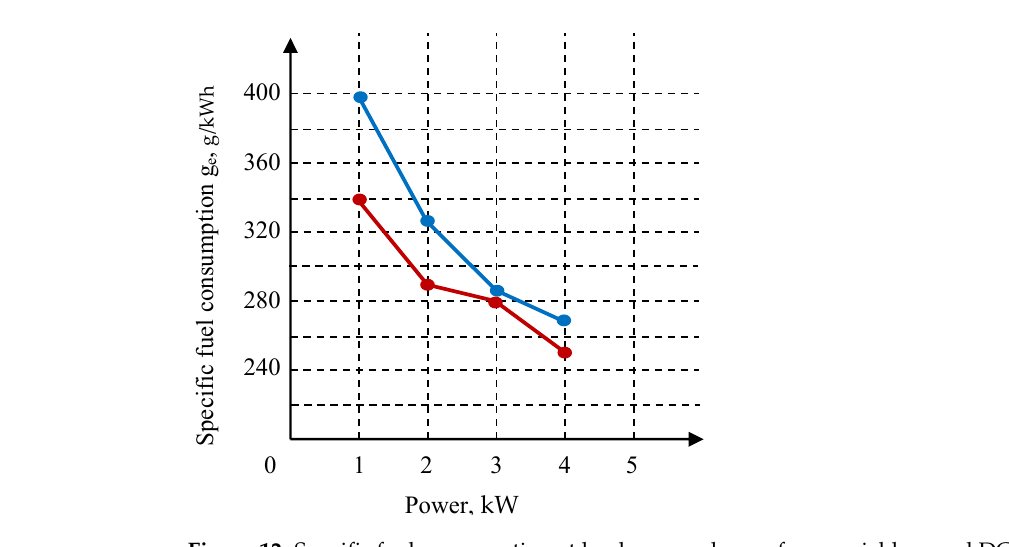
Figure 12. Specific fuel consumption at load power change for a variable speed DG (red line) and a fixed speed DG (blue line). Reprinted with permission from Ref. [15].